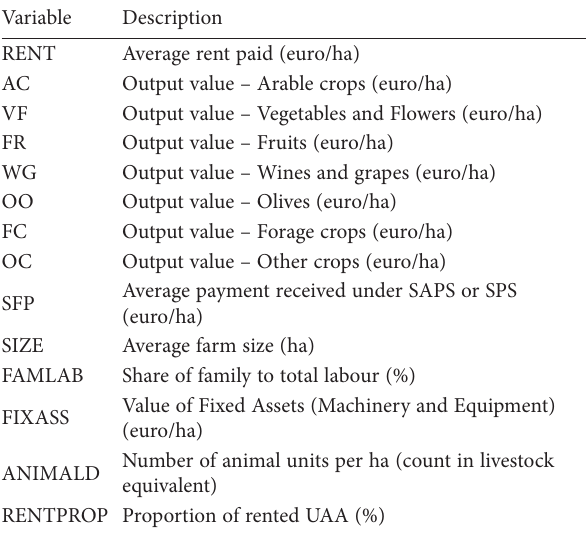
Table 1. Description of the